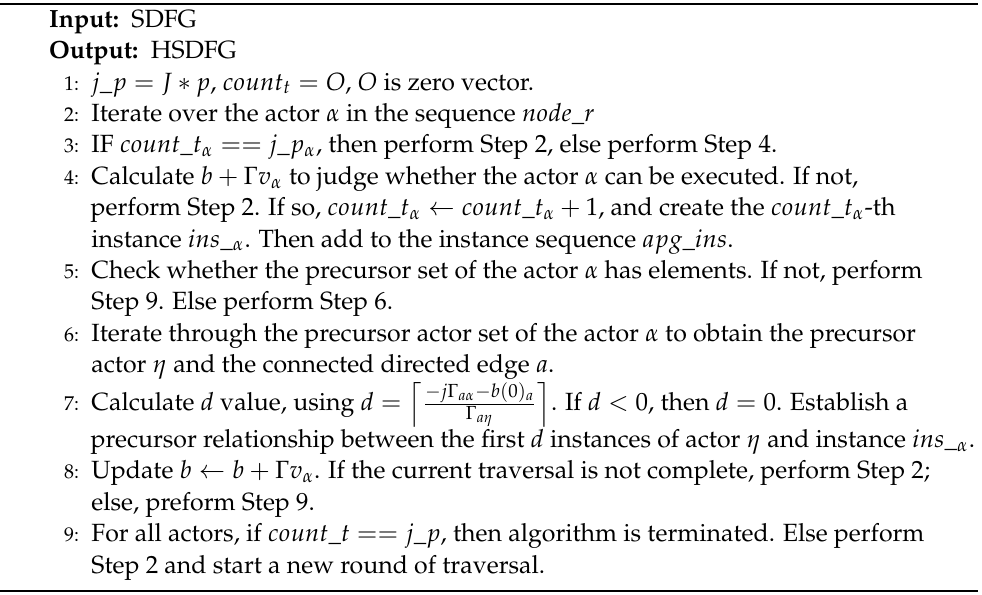
Algorithm 1: Constructing the